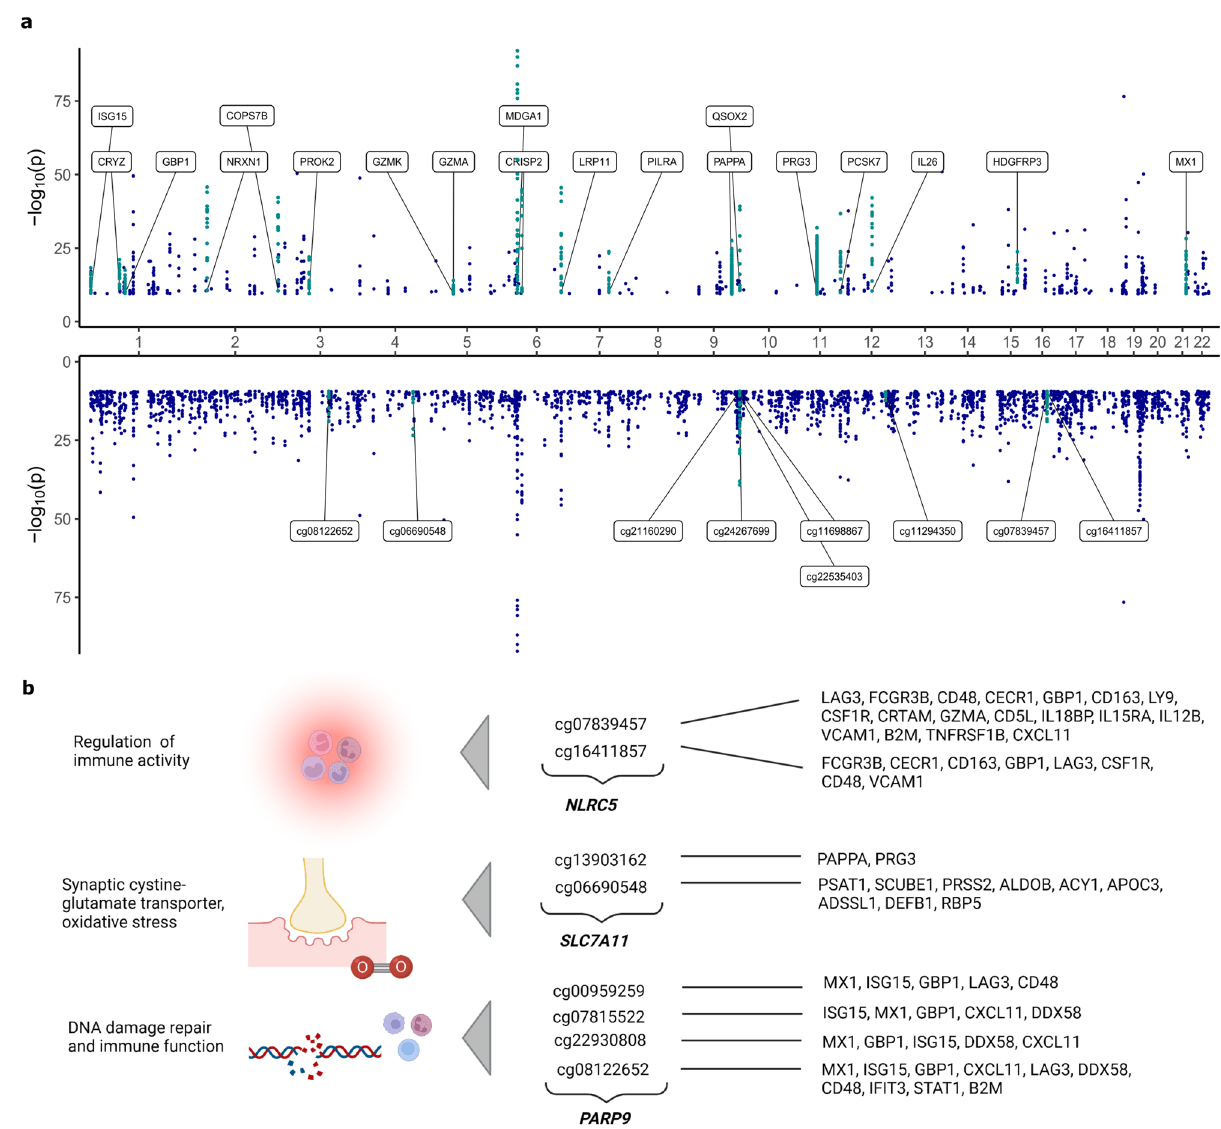
≥ 6 associations with protein levels are highlighted in turquoise on the lower